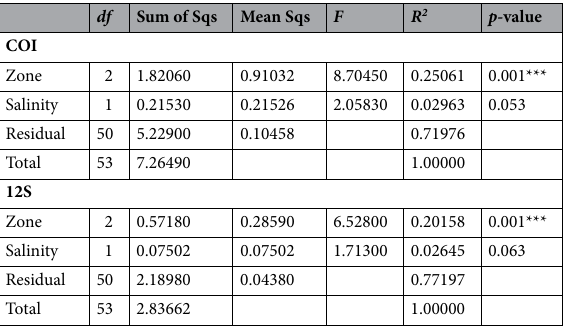
Table 1. PERMANOVA results for the zones division and site salinity levels in fish community composition. Analysis was calculated using Bray–Curtis distances for both COI and 12S metabarcoding assays. *** p <